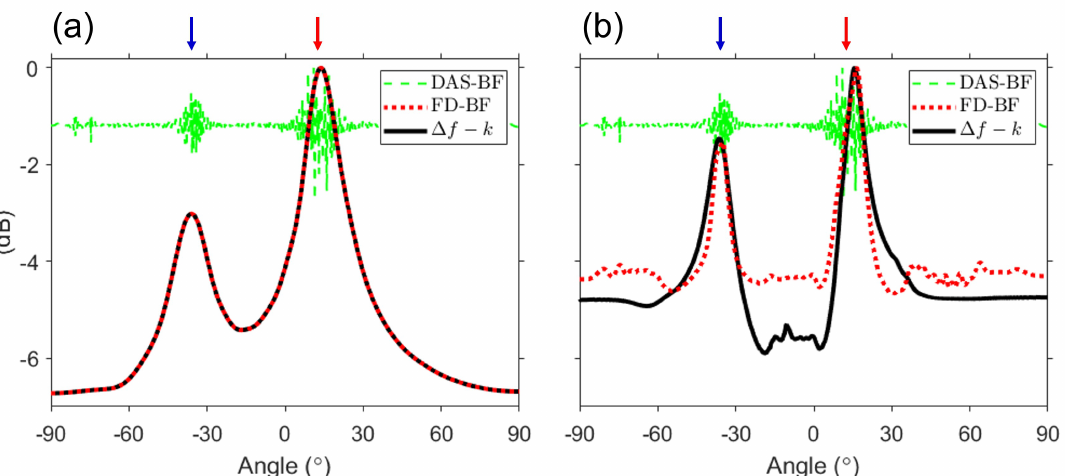
Figure 5. For simulation data, comparison of the ∆ f – k analysis (black solid line) with FD beamforming (red dotted line) double averaged over 0 ∆ f (a) 200 Hz (design frequency) or (b) 1400 Hz with DAS ≤ ≤ beamforming (green dashed line). For double averaging, the ∆ f interval is 1 Hz, and the gray-shaded region in Figure 4 is excluded. Along with FD beamforming, the ∆ f – k analysis has the ability to estimate any angle within the design frequency. By contrast, the sidelobes of the ∆ f – k analysis are lower than those of FD beamforming when averaging over all difference-frequency bands, because the grating lobes of FD beamforming have the same function as adding background noise.